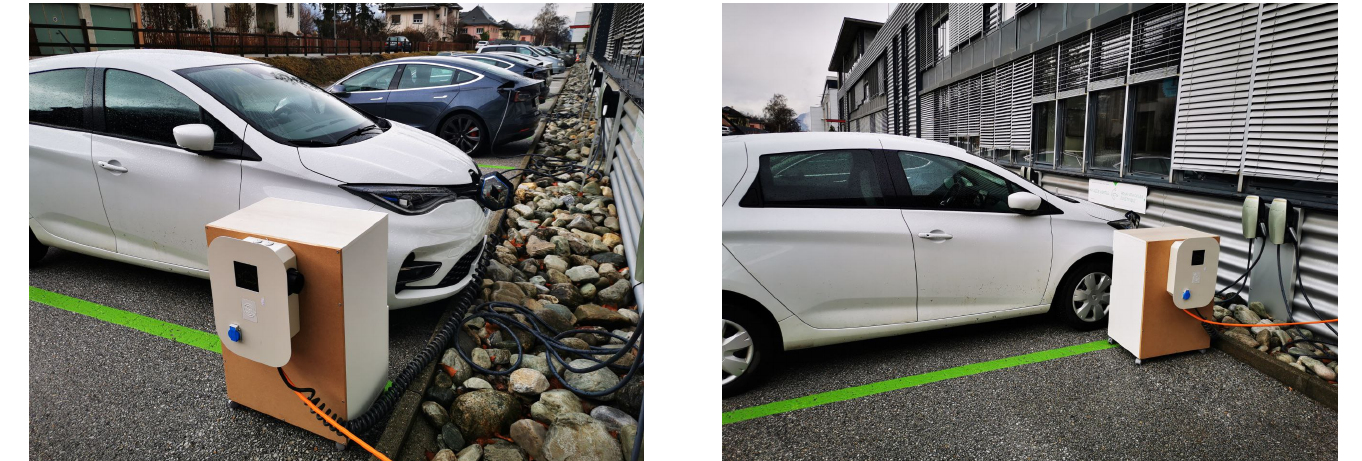
Figure 14. Real-world test